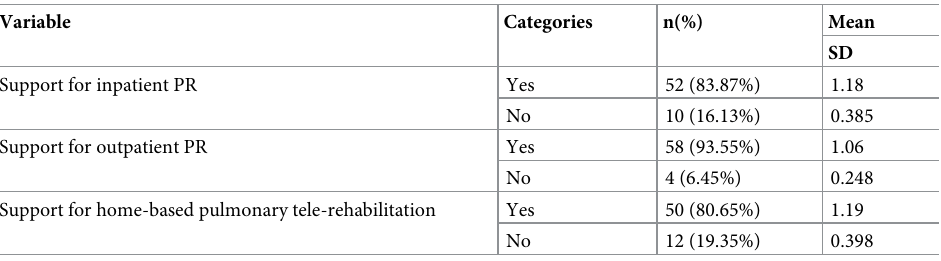
Table 6. Support from physicians to different types of pulmonary rehabilitation (PR), N =